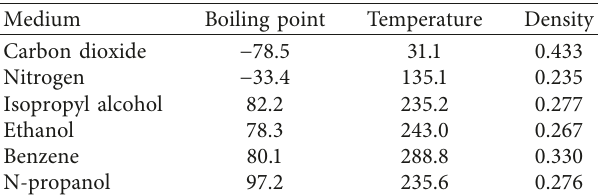
Table 4: Critical parameters of common media.